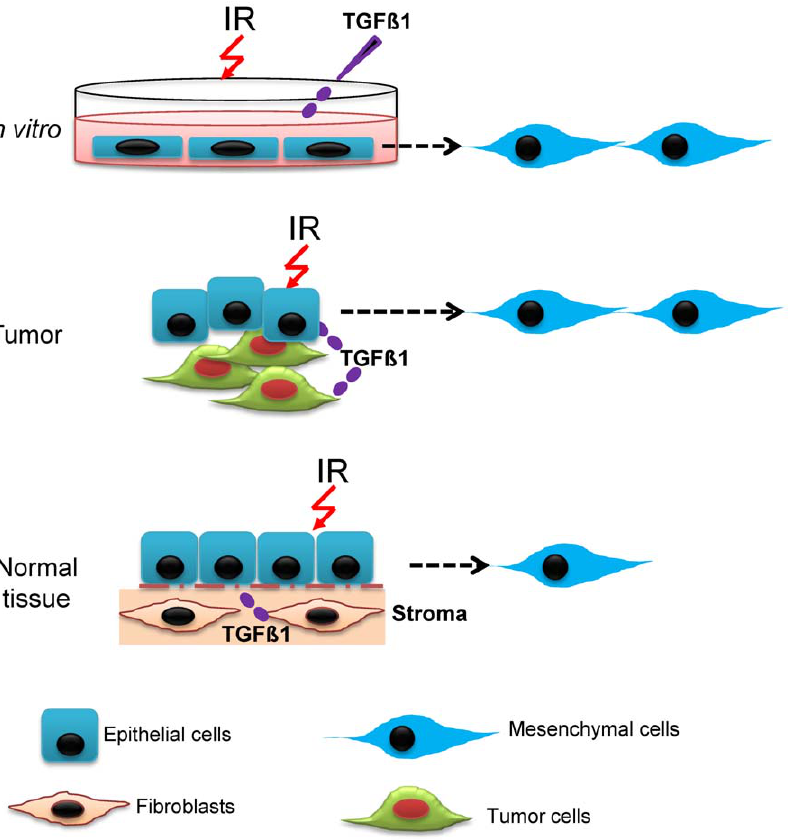
Figure 6. Schematic illustration of EMT induction in monolayer cell culture, cancerous tissue and normal tissue following proton irradiation. EMT occurs with different frequency and depending on the context of system studied. High levels of activated TGF b 1 in vitro or in cancerous tissue, enhance EMT after proton irradiation. Also the presence of other mutations such as p53, EGRF, Ras, etc . likely presents different mechanisms of EMT. In contrast for normal tissues, TGF b 1 is activated only at physiological levels at varying times, leading to a stochastic induction of EMT following proton irradiation.